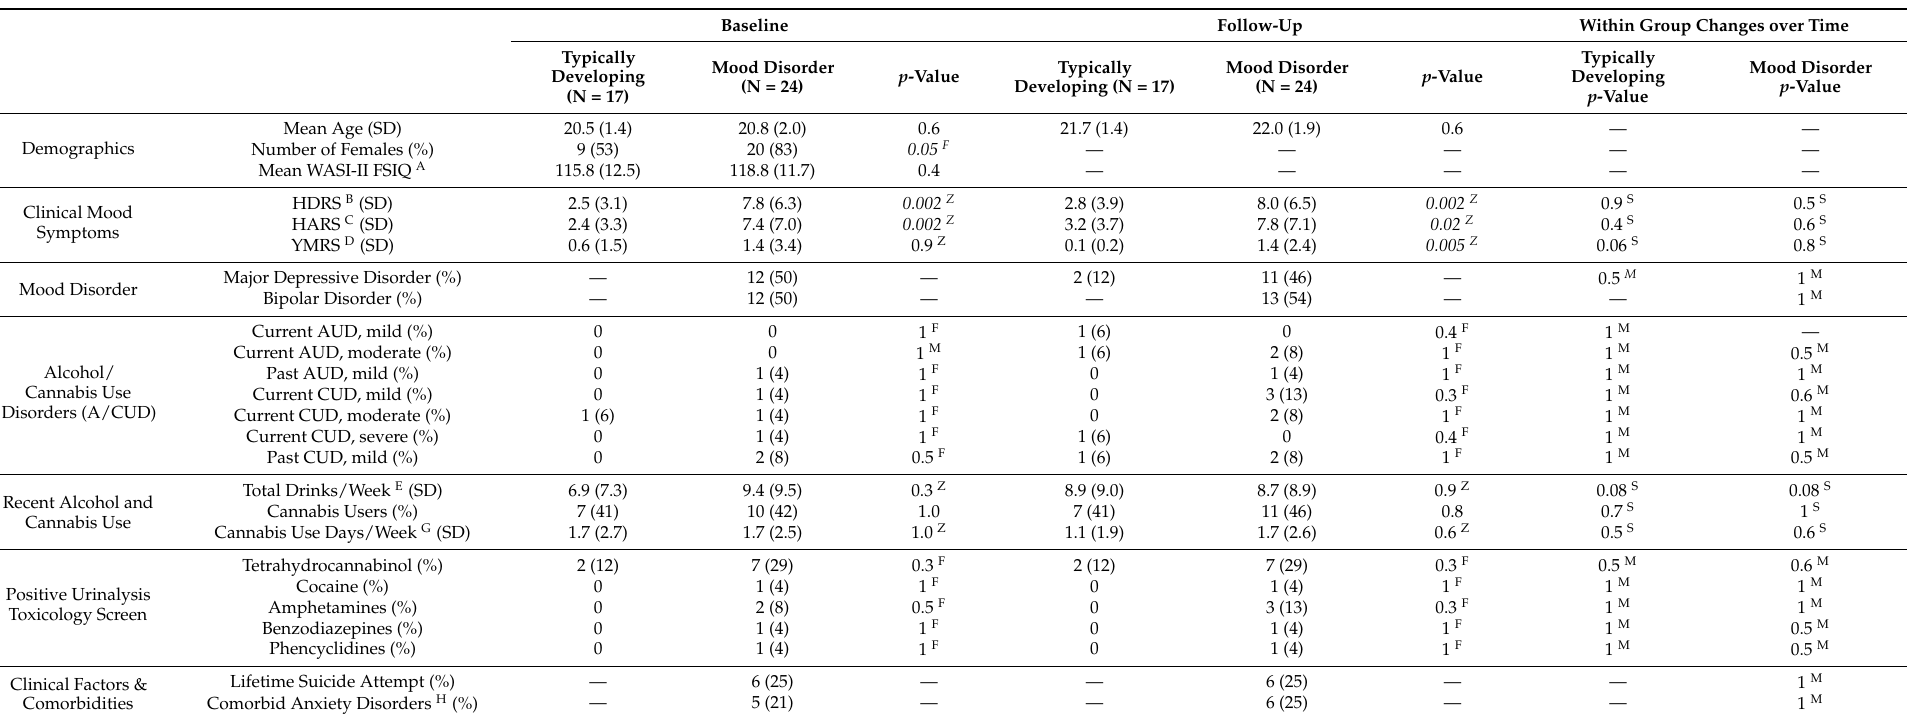
Table 1. Demographic and clinical characteristics in typically developing young adults and young adults with a mood disorder at baseline and follow-up